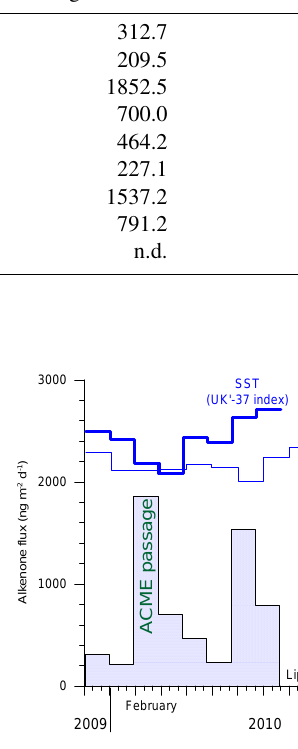
the Cabo Verde islands combined with low growth rates